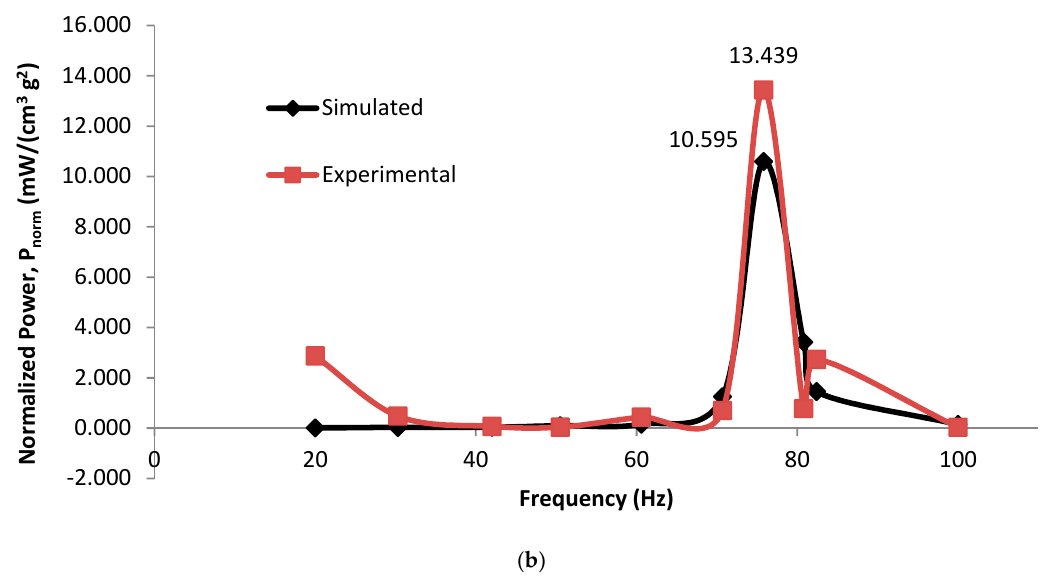
Figure 23. Normalized power against ( a ) wind speed ( b ) frequency.